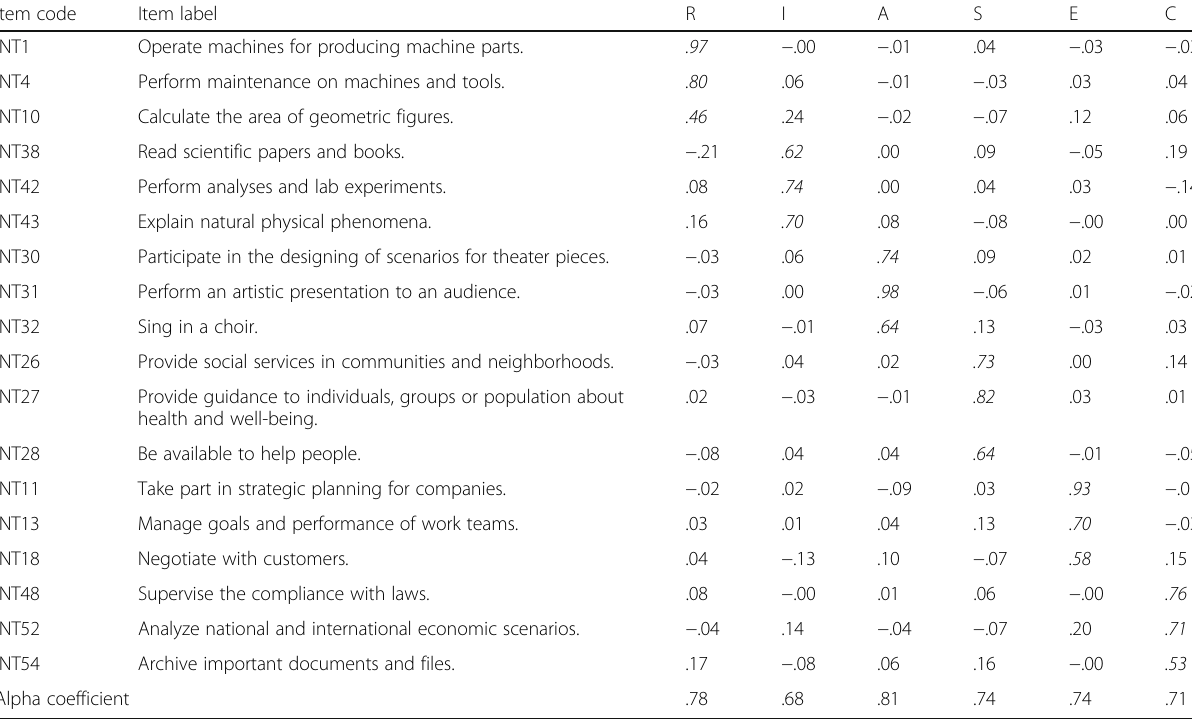
Table 2 Final 18-item, 6-factor solution Item